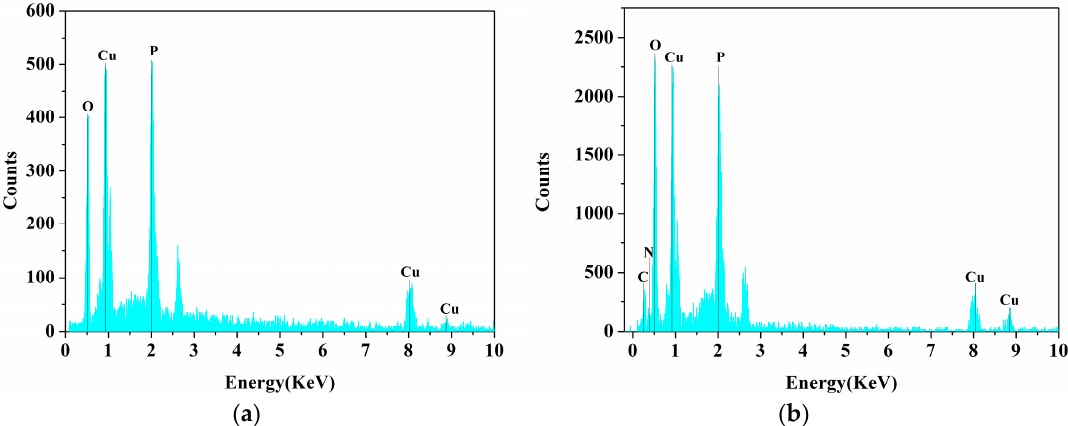
Figure 3. Energy-dispersive X-ray spectroscopy (EDS) spectrum of Cu 3 (PO 4 ) 2 ·3H 2 O matrices without laccase ( a ) and laccase-incorporated nanoflower ( b ).